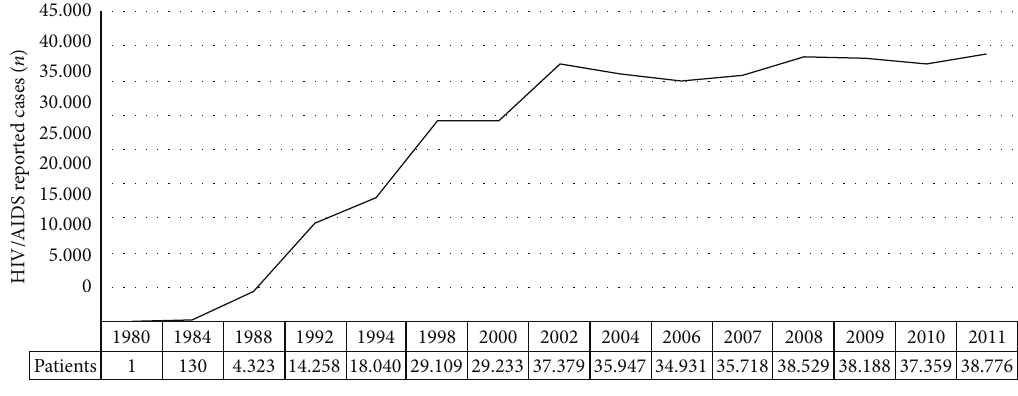
Figure 1: Annual HIV/AIDS reported cases in Brazil, 1980–2011.